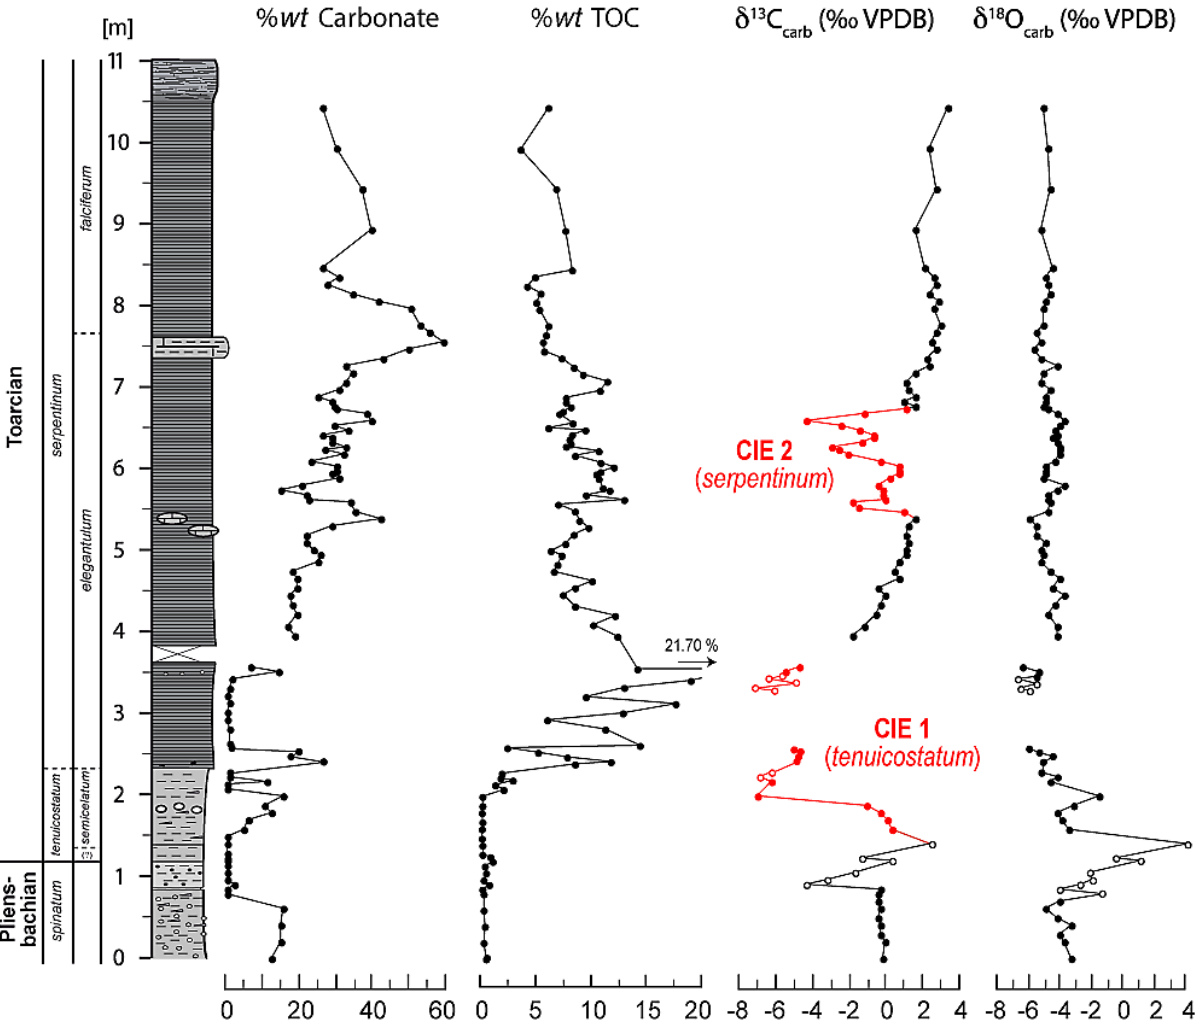
Figure 4. Evolution in carbonate (%CaCO 3 ) and total organic carbon (%TOC) content, and stable isotopes (carbon and oxygen) from car- bonate for the Bascharage section. Open circles indicate samples with very low (typically <10%) carbonate content, challenging the validity or meaning of stable isotopes data in such clay facies. During the Early Toarcian, the oceanic anoxic event is expressed by the overarching positive trend in carbon isotope ratios, accompanied by an increase in the carbonate (coccolith) content in Bascharage. Red portions of the curves represent the CIEs: a first one (CIE 1) with a magnitude of − 6‰ in the tenuicostatum zone, which can be stratigraphically assigned to the widely documented T-CIE. A subsequent − 6‰ and stepped CIE (CIE 2) in the serpentinum zone is expressed in well-preserved coccolith-bearing sediments. Coeval oxygen isotope shows heavier signatures during each of the fourth step of the CIE 2 (see Fig. 6).